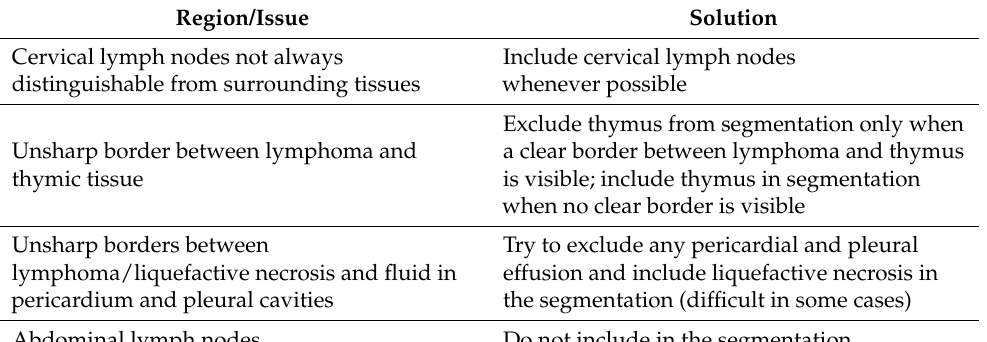
Table 1. Challenges encountered by the radiologists during segmentation and solutions used in the database.